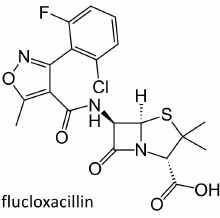
Figure 3. Chemical structure of